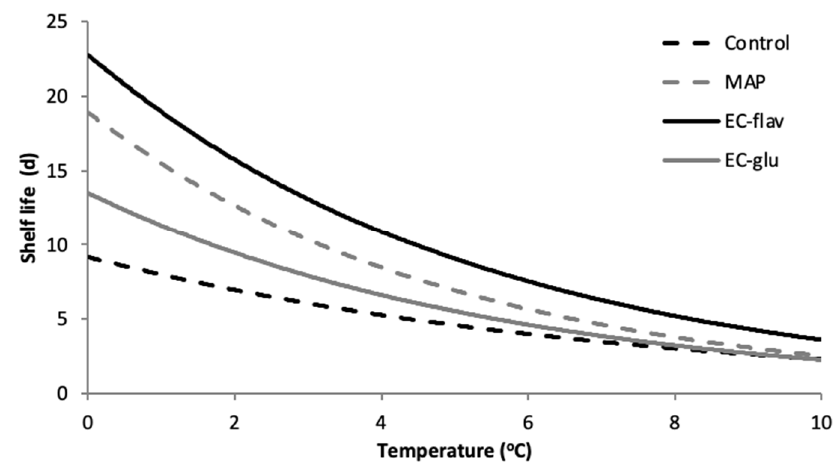
Figure 6. Shelf life (d) of chicken stored at 0–10 °C.